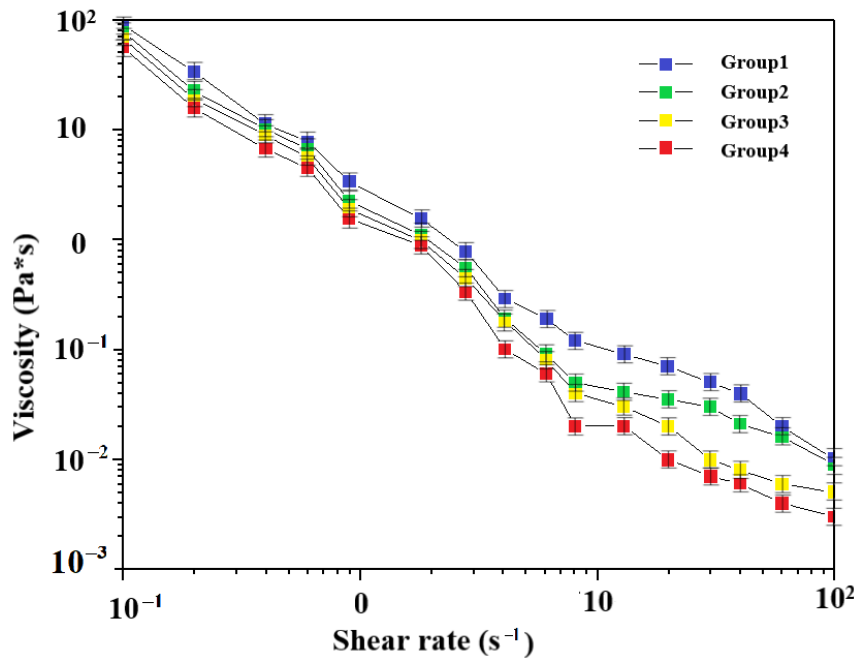
Figure 6. Results of viscosity characteristics of the composite slurry. Table 2. Printed parameters of each composite